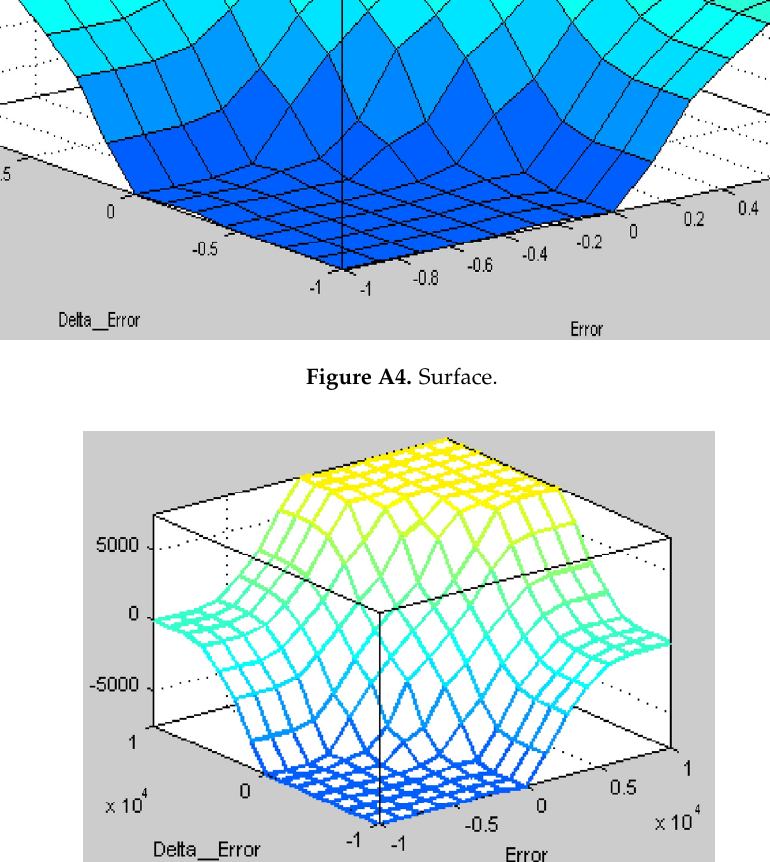
FigureA5. Mesh. The figure has been changed.